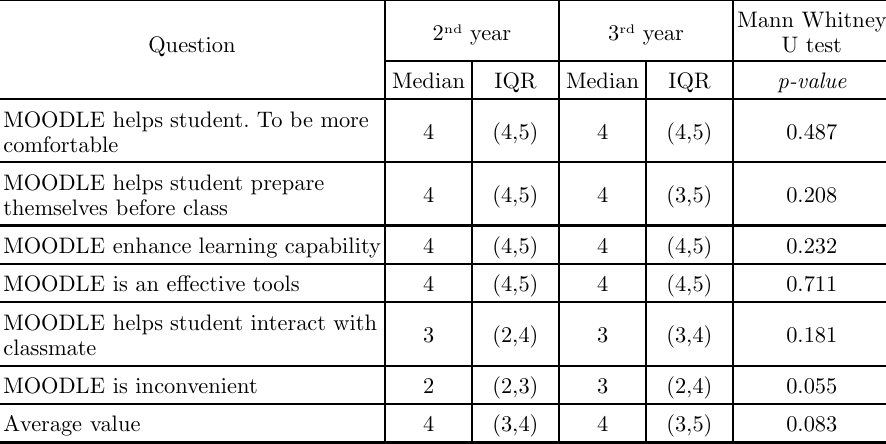
Table 2. Students’ attitudes towards Moodle